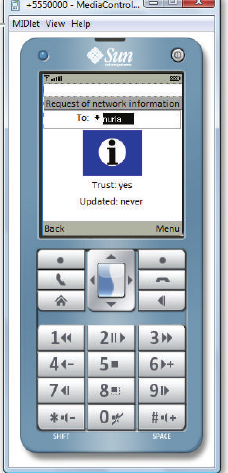
Figure 14: BackOffType = 3.